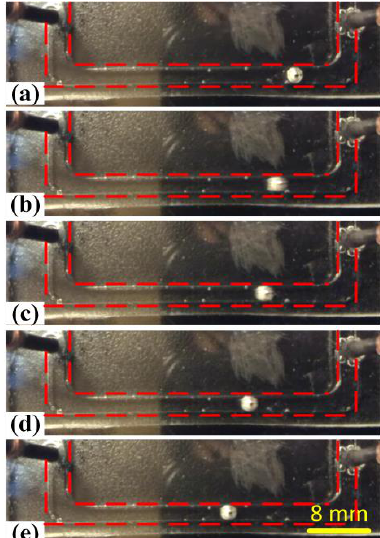
Figure 9. ( a – e ) Forward locomotion of the liquid metal slug between two driving electrodes upon the application of a sinusoidal wave signal of 50 Vpp at 4 V offset at the frequency of 30